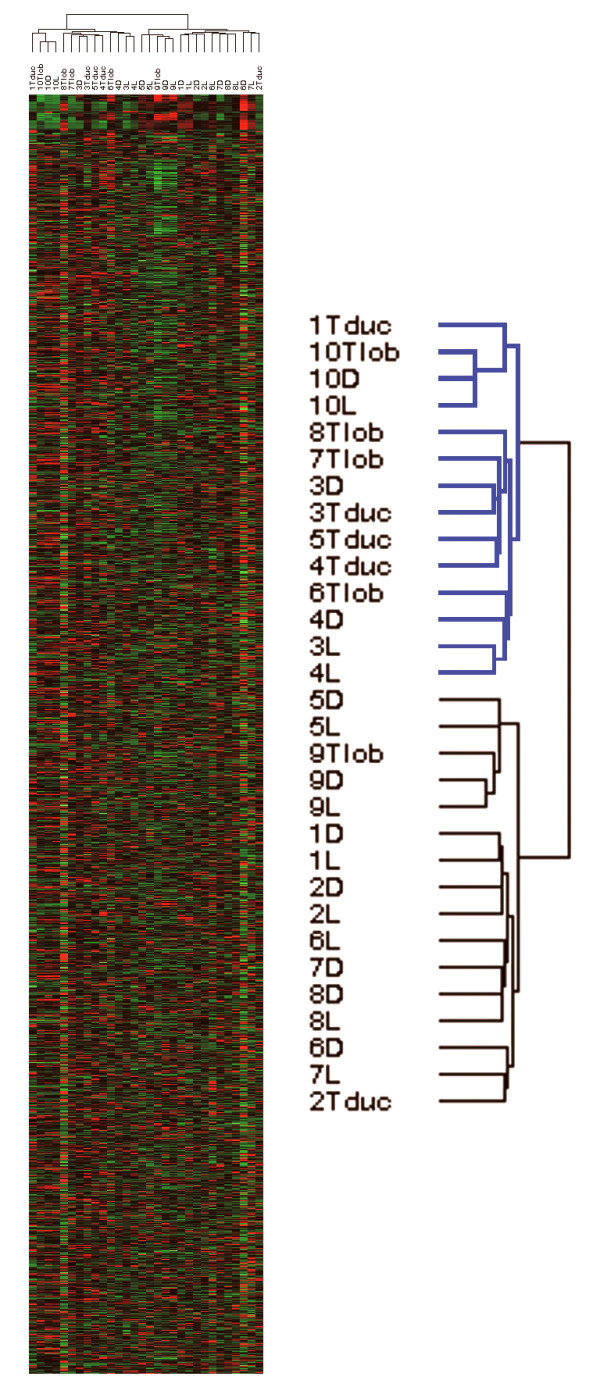
Unsupervised hierarchical clustering of all samples using all probe sets. No tumor types are grouped together, however, two large clusters are evident: one (blue) mainly consists of tumor cells and the other (black) mainly consists of normal cells. This suggests differences in global gene expression profiles of tumor and normal cells. 1–10, case numbers; D, ductal normal cells; L, lobular normal cells; Tduc, ductal tumor; Tlob, lobular tumor.